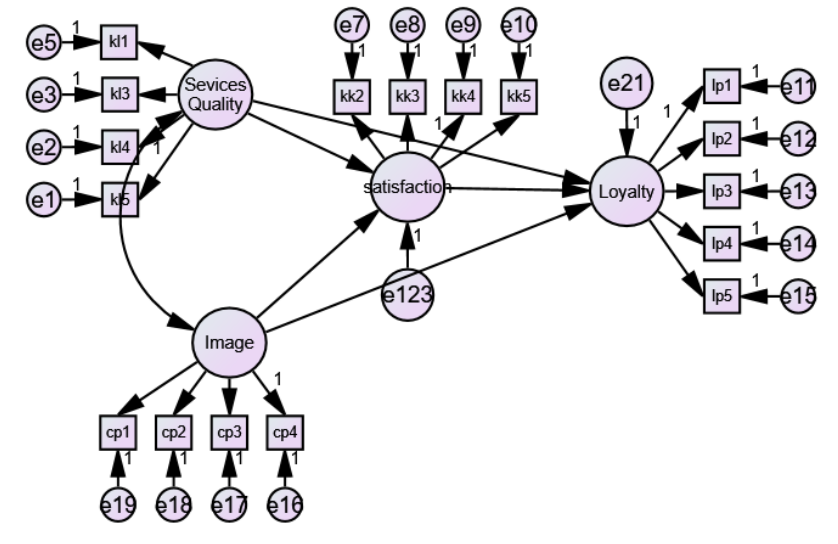
Figure 2: Research Model in